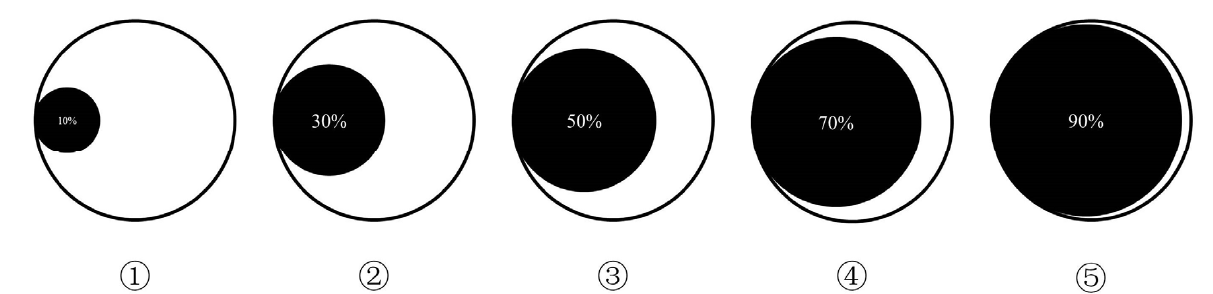
Figure 3. Diagram of risk information proportion. The outer circle represents the total information of the area where an emergency occurs. The inner black circle represents the risk-related (or hazard- related) information, and the blank part represents the information related to the area but nothing to do with the risk or hazard. ① indicates that the proportion of risk information is small, such as 10%, while ⑤ indicates that the proportion of risk information is large, such as 90%; ② , ③ , and ④ represent different proportions of risk information between small and large, such as 30%, 50%, and 70%.